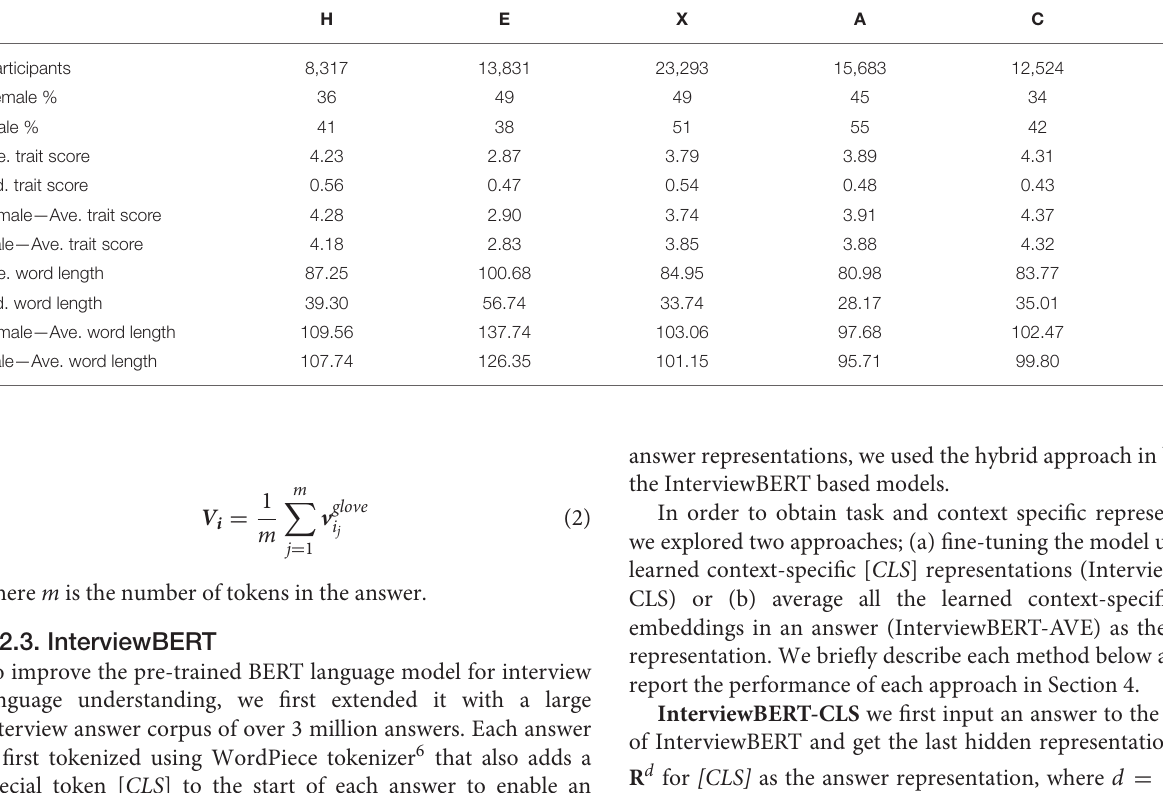
TABLE 1 | Statistics of the dataset used in experiments. Std. is in short for “ standard deviation ” and Ave. is in short for “ average .” Gender information was not available for all participants. H E X A C O